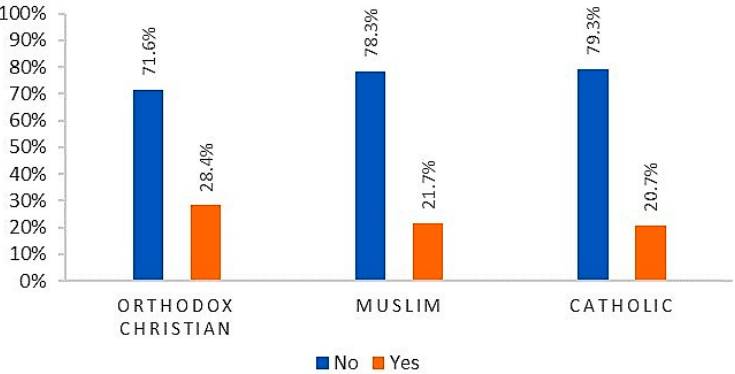
Figure 20. Confessionality and engaging in informal practices.